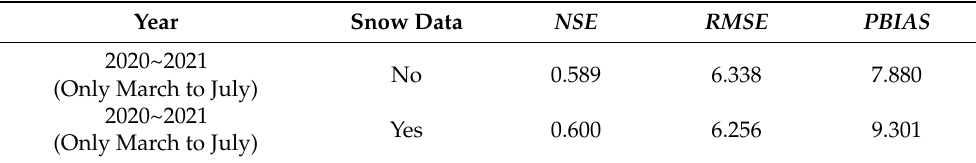
Table 2. Evaluation parameters for the random forest model of the Xiying River Basin from March to